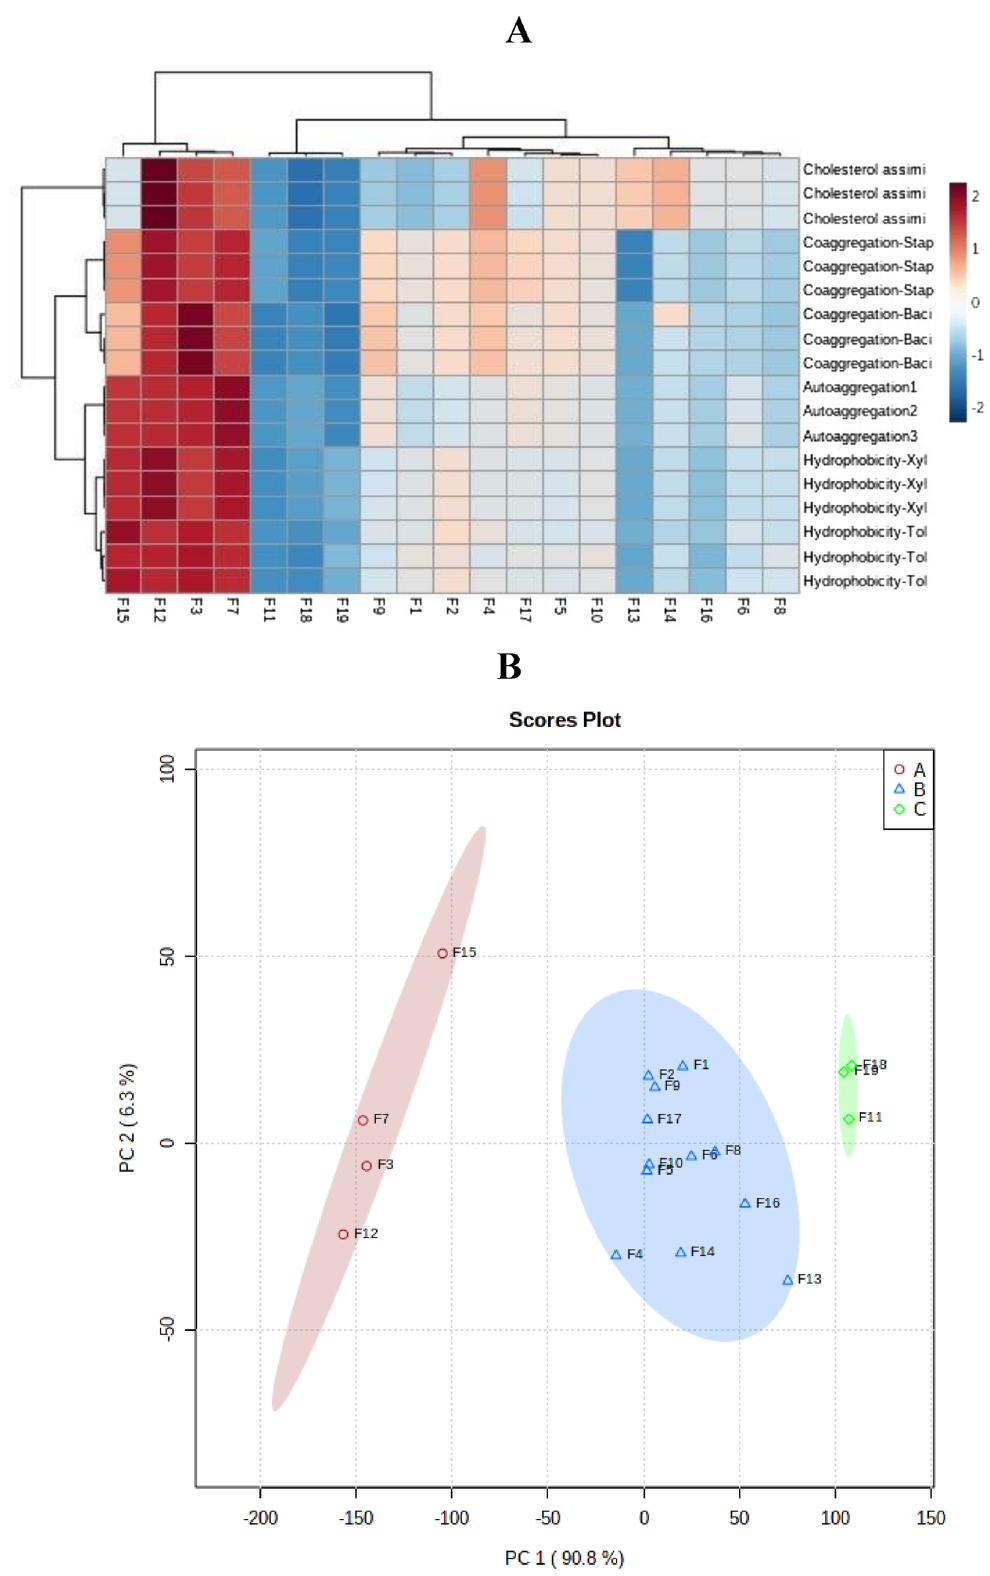
Figure 4. Cluster analysis of isolates based on probiotic characteristics using heat-map ( A ) and PCA ( B )